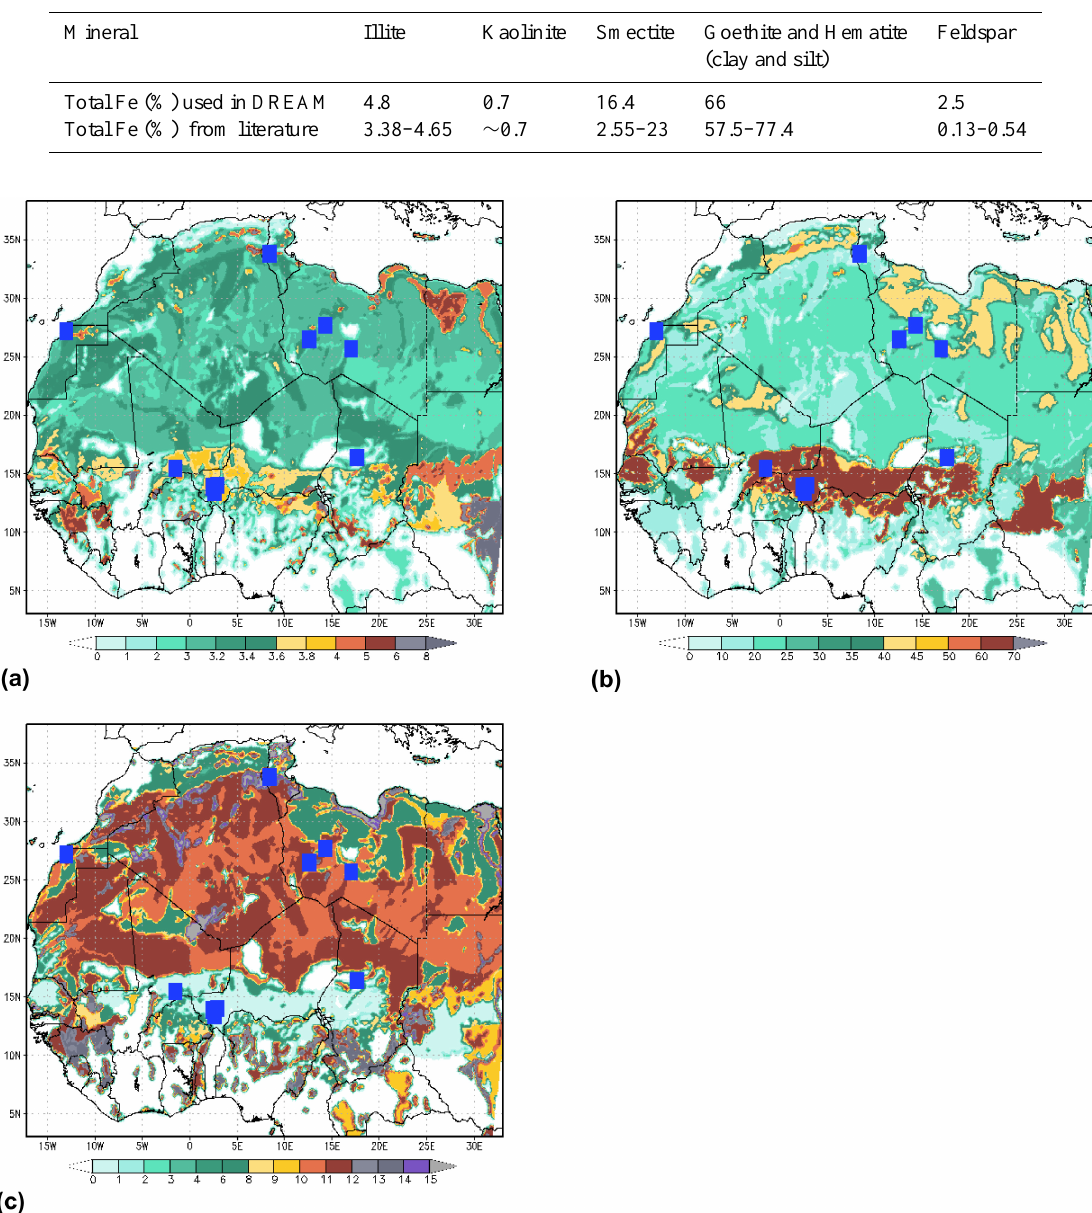
Fig. 1. Geographic distribution of iron-related soil parameters over northern Africa. (a) Total iron; (b) Free-to-total iron ratio f ; (c) Potential solubility s pot